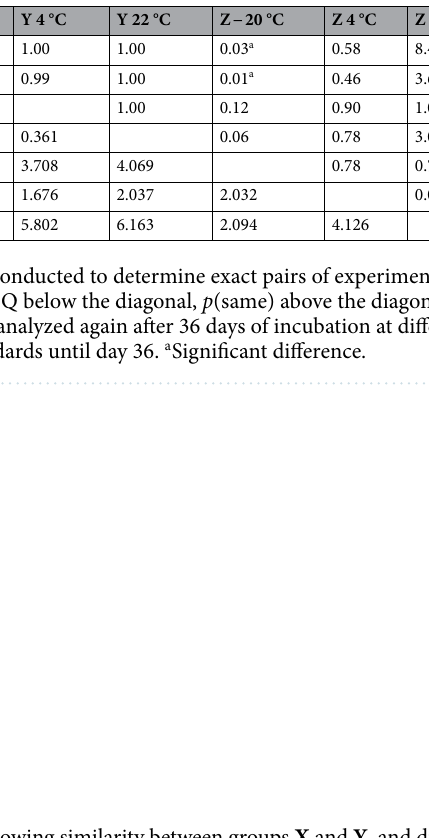
Figure 5. Cluster analysis results showing similarity between groups X and Y , and dissimilarity between X or Y and Z at all three temperatures of this study. Conditions are color coded as in Fig. 1. (Algorithm: Ward’s method; cophenetic correlation: coefficient: